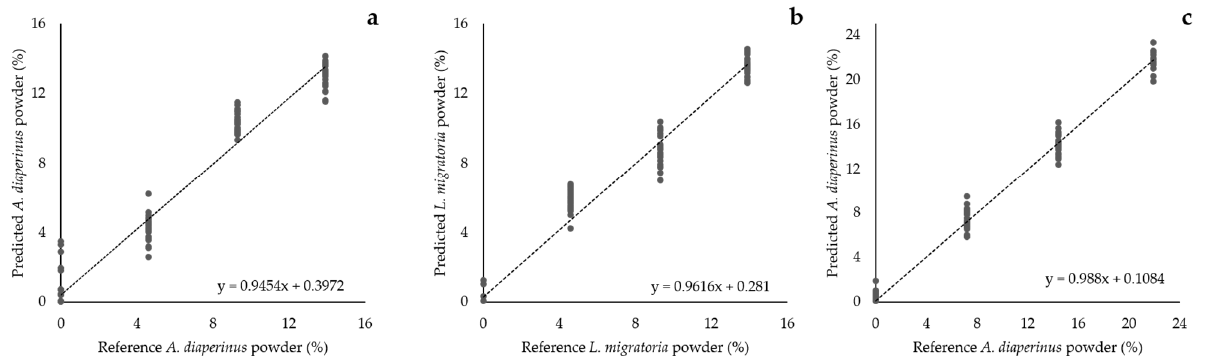
Figure 11. Modeling equations of the calibrated partial least square regressions (PLSR) from the models ( a ) A d PLSR, A. diaperinus dough PLSR model; ( b ) L d PLSR, L. migratoria dough model; and ( c ) A s PLSR, A. diaperinus 3D-printed baked snacks PLSR model.